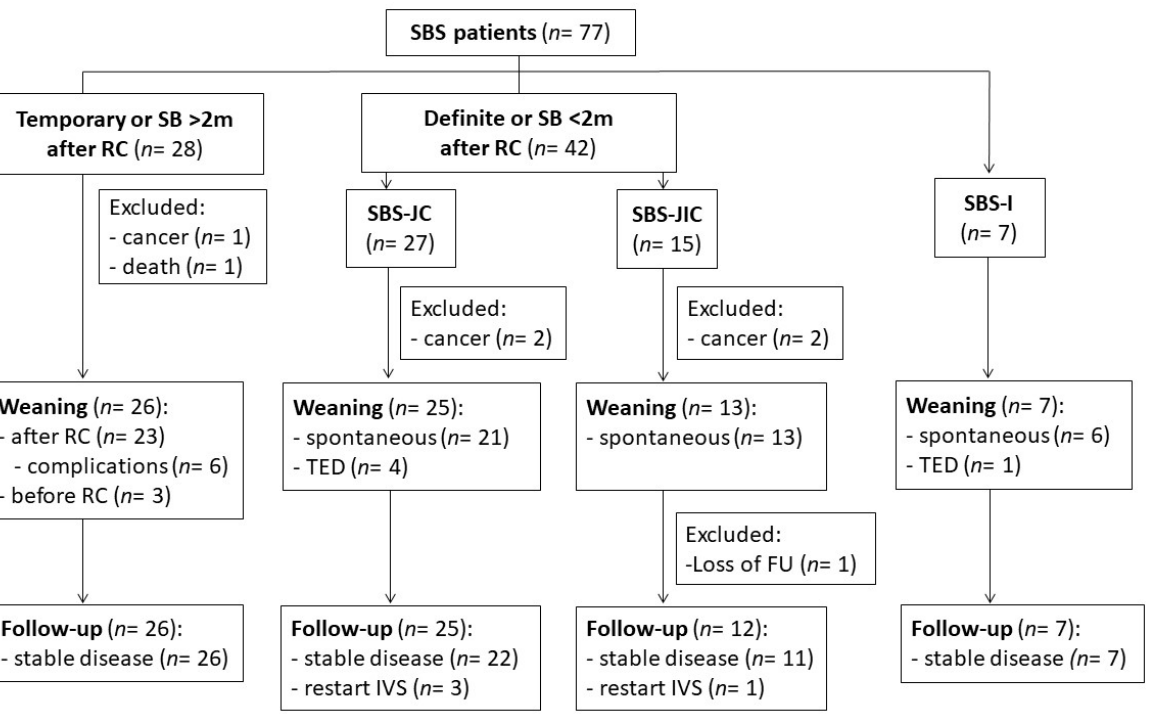
Figure 1. Flowchart of SBS patients during IVS and FU after weaning. Continuity surgery (RC) was performed in temporary and definite SBS patients with a colon-in-continuity. Patients weaned on TED (four SBS-JC, one SBS-I patients) were analyzed separately. Abbreviations: follow-up (FU), in- travenous support (IVS), small bowel (SB), short bowel syndrome (SBS), ileostomy (SBS-I), jejuno- colic (SBS-JC) or jejuno-ileal anastomosis (SBS-JIC), restoration of continuity (RC), and teduglutide (TED).